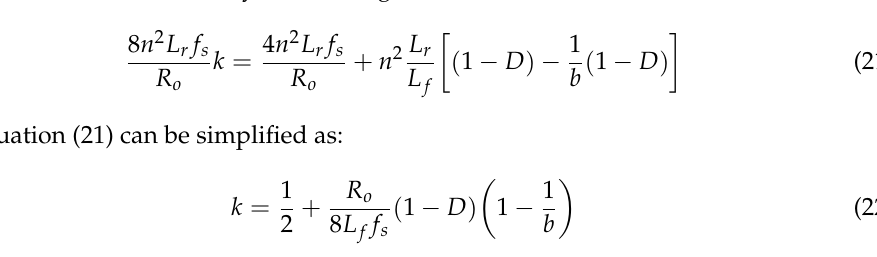
P = 400 W; P o = 400 W; R o = 2.667 Ω , P o = 600 W; R o = 2 Ω , P o = 800 W). o